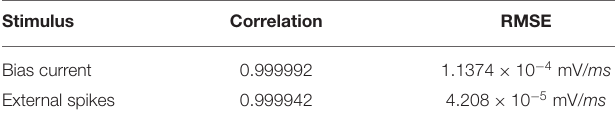
TABLE 3 | Correlation and RMSE between BMTK and Loihi membrane potential values.